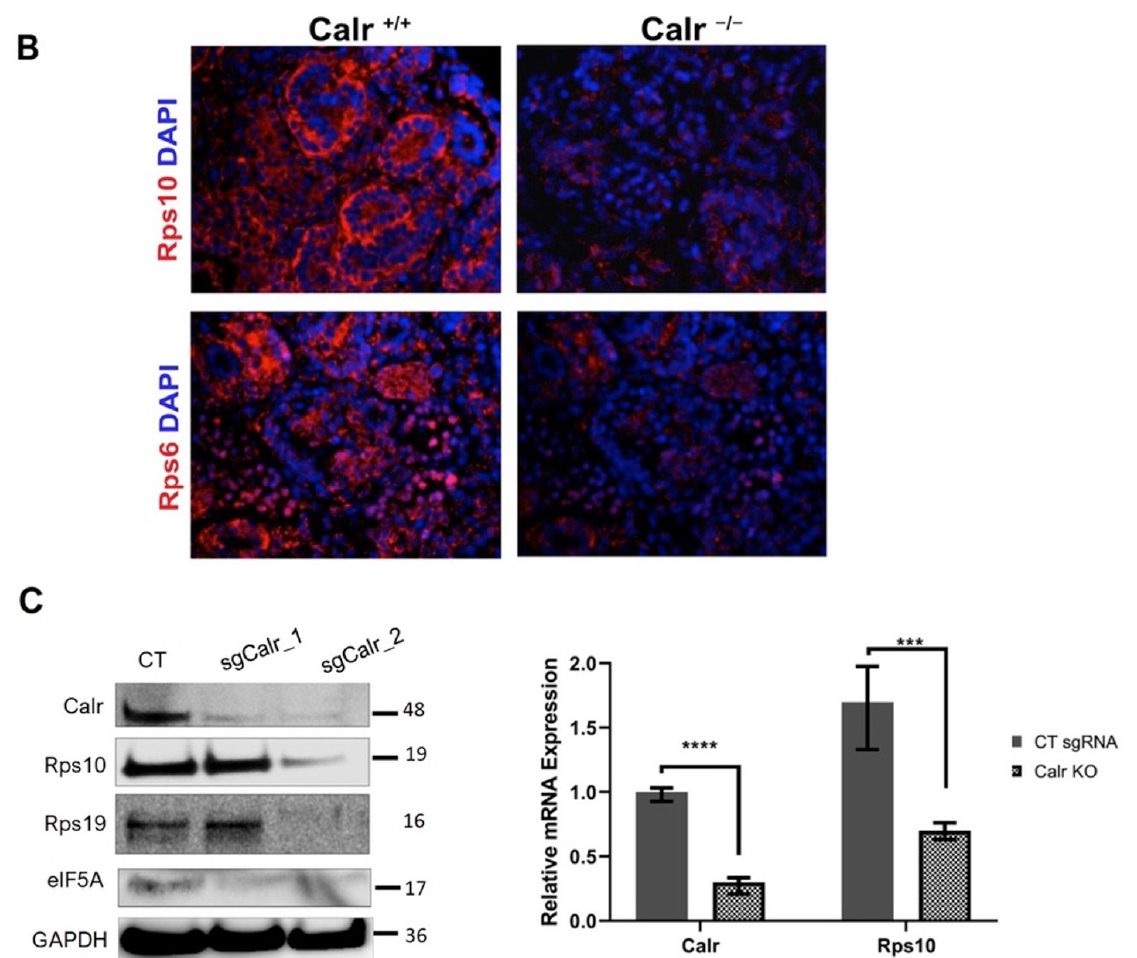
Figure 7. Calr deficiency is associated with down-regulation in ribosomal protein expression. ( A ): Western blot analyses of ribosomal proteins Rps10, Rps19, and Rps26 in protein extracts from Calr + /+ , Calr +/ − , and Calr − / − embryonic kidneys. Embryonic kidneys were harvested from three different pregnant Calr +/- mice. After genotyping, embryos from the same mother and genotype were grouped together and their embryonic kidney protein extracts were pooled together. After protein estimation Western blot analyses were performed in triplicate for each investigated protein. For the comparative analysis of the samples, the one-way ANOVA was used. The results are presented as the mean ± s.d. from at least three independent experiments. Differences were considered statistically significant when p < 0.05. ( B ): Immunofluorescence staining against Rps10 and Rps6 in Calr +/+ and Calr − / − embryonic kidney tissue sections with a magnification of 20×. ( C ): Western blot analysis of protein extract from MDCK cells (left) and mRNA quantification after the knockout of Calr in MDCK cells (right). Calr was knocked out using the CRISPR/cas9 system with two different sgRNAs. Western blots were probed with Calr, GAPDH, Rps10, Rps19, and eIF5a antibodies. Calr and Rps10 mRNA quantifications in the sgCalr-2 sample were carried out using qPCR. Down-regulation of Calr using the CRISPR/cas9 system revealed an association between Calr deficiency and alteration in ribosomal protein expression. Significant differences: (**) p < 0.01, (***) p < 0.001, (****) p < 0.0001.